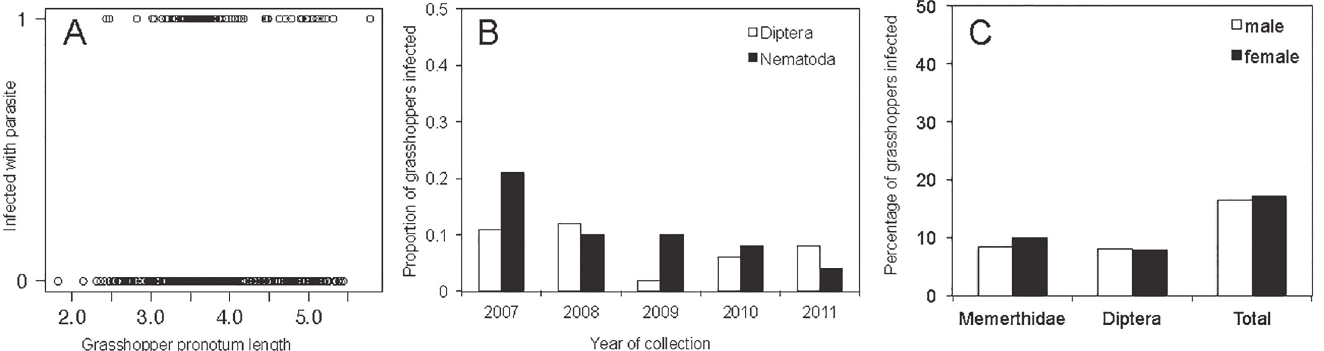
Fig 2. Patterns of parasite presence in Kosciscola tristis : (A) Relationship between grasshopper body size and whether or not they were infected. (B) Prevalence of Nematoda and Diptera in K . tristis over five years ranged between 3.5% to 21.4%. The overall prevalence of Nematoda and Diptera in K . tristis (n = 640) was 7.8% and 7.7%, respectively, (C) Proportion of males and females infected with Nematoda and Diptera.